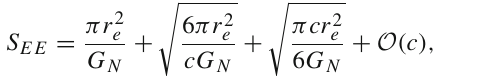
= t a b . In addition, we